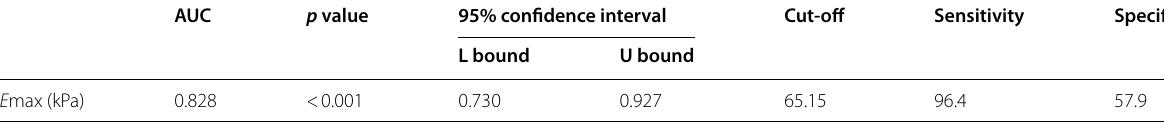
Table 2 The calculated E max cut-off point to differentiate benign from malignant lesions AUC p value